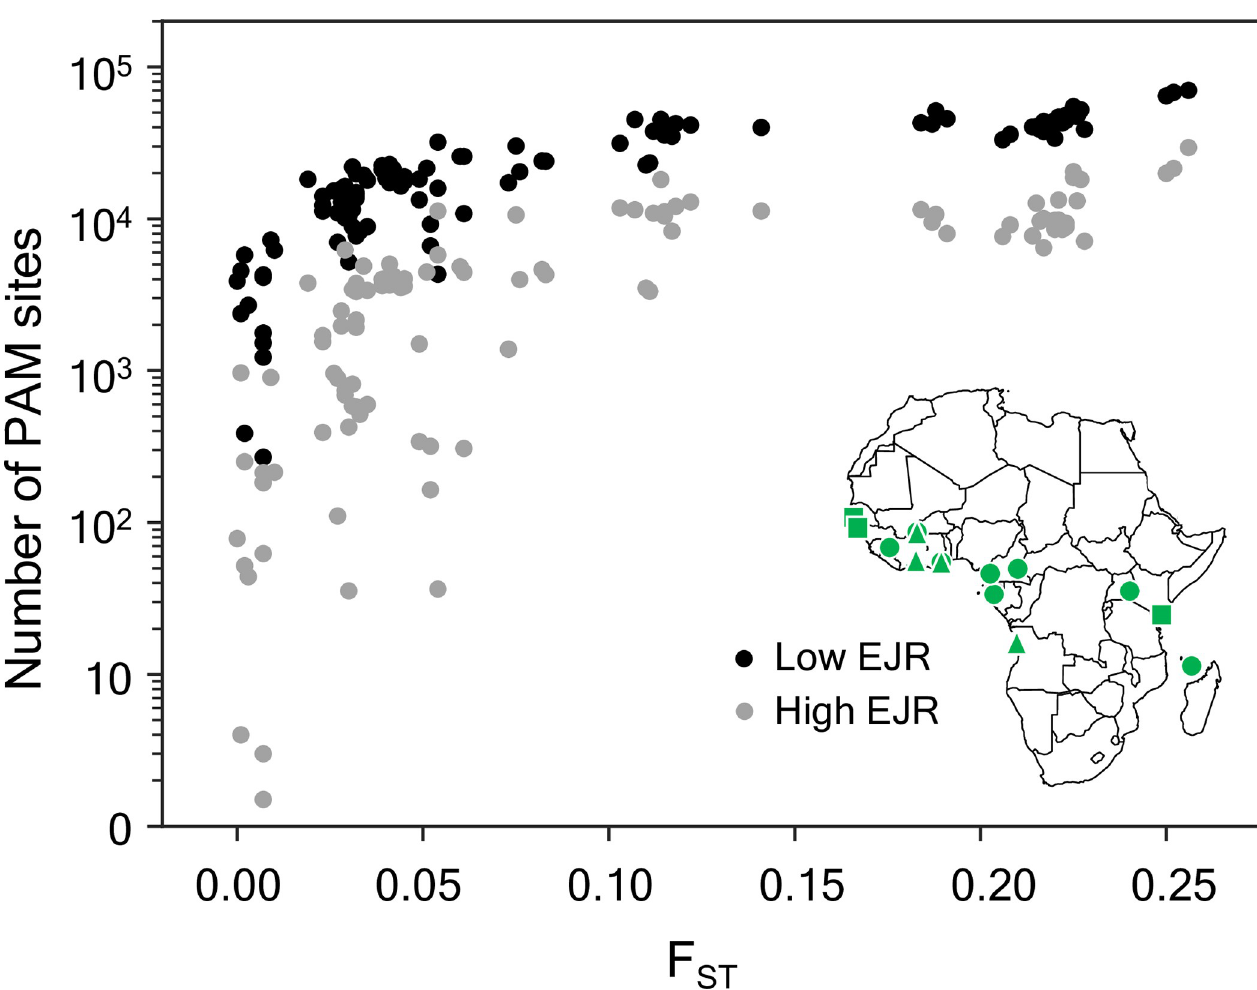
Fig 6. Number of suitably differentiated PAM sites as a function of the overall differentiation between pairs of An . gambiae s.l. populations. For each pair of populations we plot the average number of autosomal PAM sites with frequencies of > 36% in one population and < 13% in the other (low EJR scenario, black dots, equivalent to frequencies of resistant alleles of < 64% and > 87%, respectively) or > 88% in one population and < 33% in the other (high EJR scenario, grey dots). F ST values were obtained from The Anopheles gambiae 1000 Genomes Consortium ([18], Supp. Fig S5). Inset shows the location and subspecies assignment of the 15 populations ( An . gambiae [circles]. An . coluzzii [triangles] or unassigned [squares]). The sample site map was generated using the cartopy python package